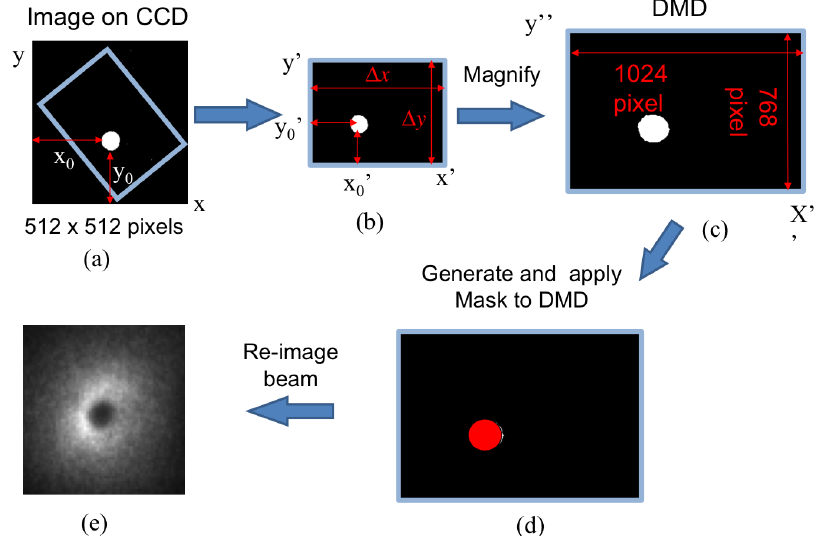
FIG. 3. Schematic of mask generation